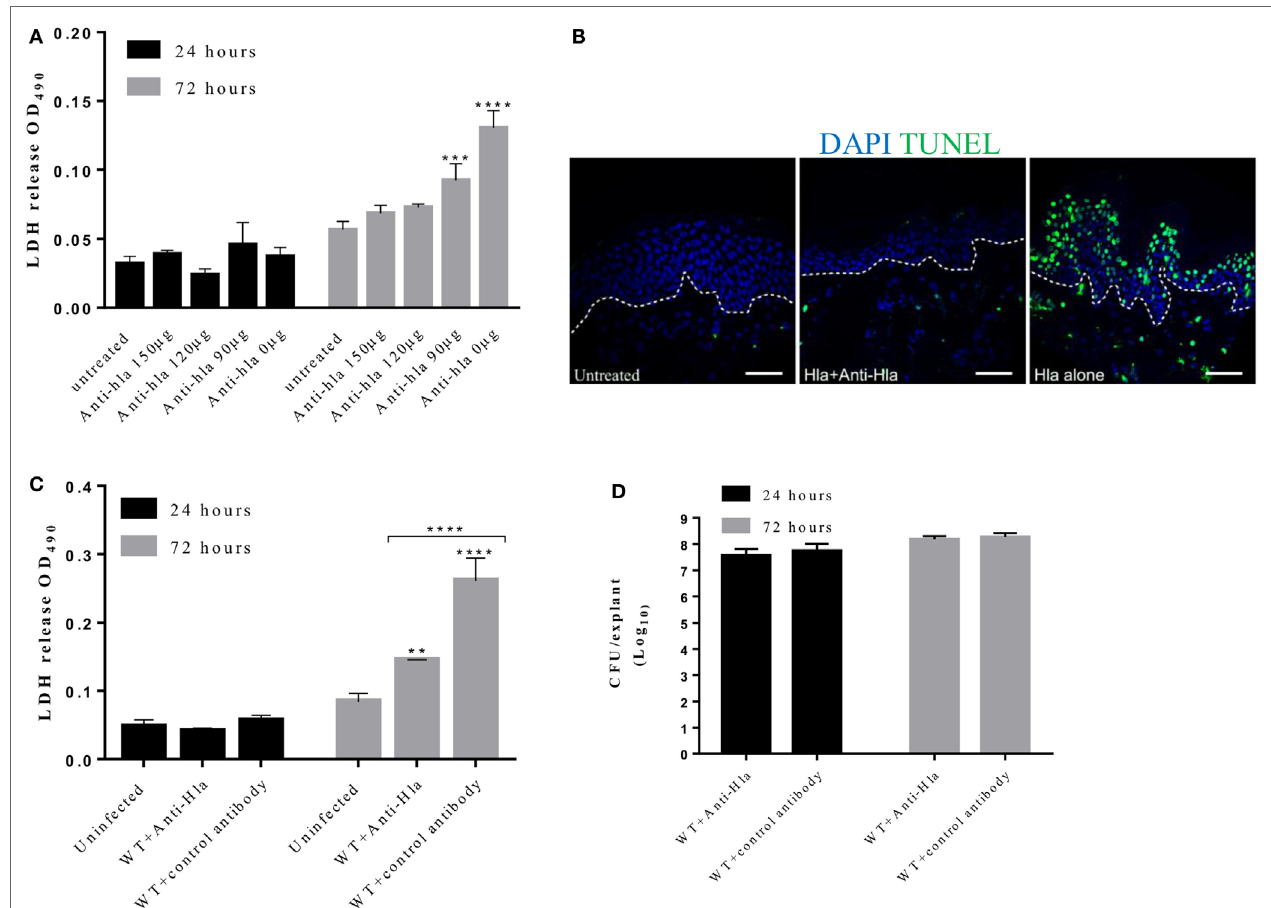
FigUre 6 | Anti-Hla antibodies mitigate tissue cytolysis but not bacteria survival during infection. Human skin explants were treated with 5 µg of Hla in combination with increasing concentrations of rabbit anti-Hla antibodies. For infection experiments, skin explants were infected with 5 × 10 5 colony-forming unit (CFU) of Staphylococcus aureus USA300 wild type in combination with 150 µg of purified rabbit anti-Hla antibodies or unspecific antibodies. (a) Inhibition of purified Hla activity by anti-Hla antibodies in a concentration-dependent manner. Each bar represents the mean ± SD ( N = 3). (B) Immunofluorescence images of skin sections showing TUNEL-positive cells in the skin treated with Hla in combination with 150 µg of anti-Hla antibodies. White dotted lines represent the boundary between the epidermis and dermis. Scale bar is 50 µm. (c) Lactate dehydrogenase (LDH) content in the medium of infected skin. Each bar represents the mean ± SD ( N = 3). (D) Bacteria CFU recovered from the skin 24 and 72 h post-infection. Each bar represents the mean ± SD ( N = 3). Statistically significant differences were determined by two-way ANOVA, with Tukey’s multiple comparison tests, ** p ≤ 0.05, *** p ≤ 0.0002, and **** p <